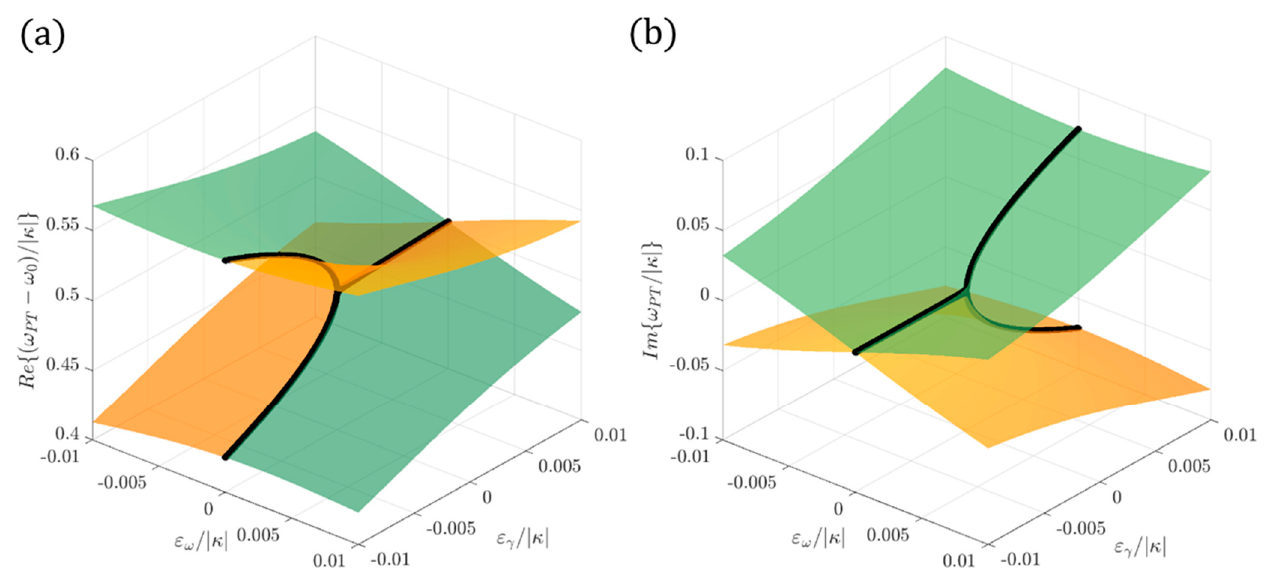
Figure 2. The real part ( a ) and imaginary part ( b ) of the eigenfrequencies of a PT-symmetric Hamiltonian for different values of the perturbations ε ω and ε γ in the proximity of an EP. Black lines identify the region where ε ω = 0.